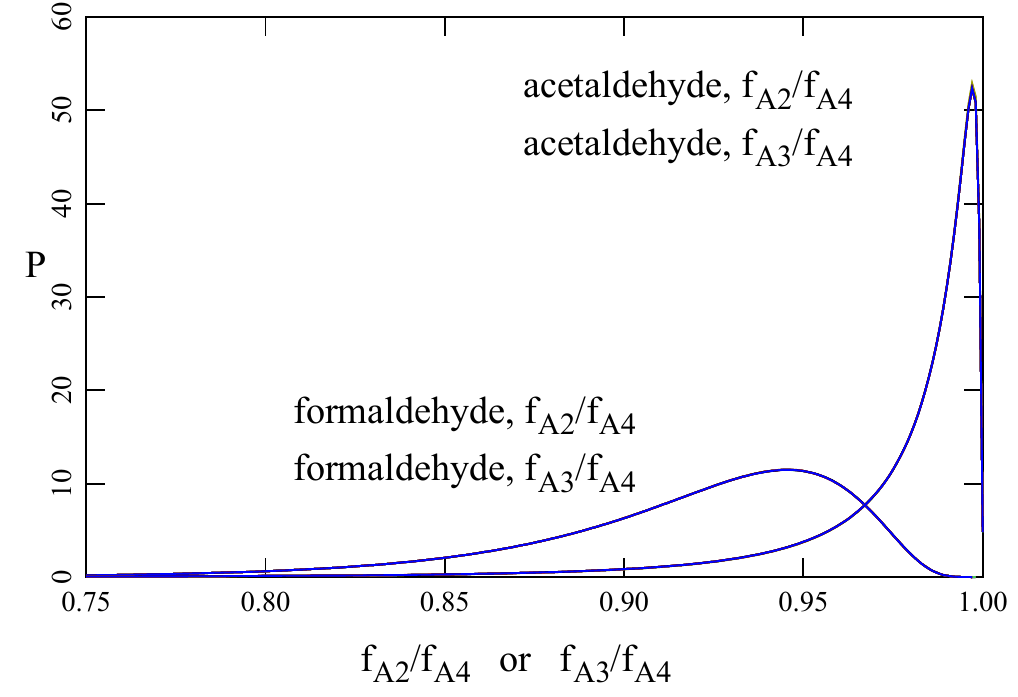
Figure 10. Distributions of f A3 / f A4 and f A2 / f A4 for the formaldehyde and acetaldehyde models. Curves for eight different values of k 21A have been plotted but are indistinguishable, as are the curves for f A2 and f A3 .